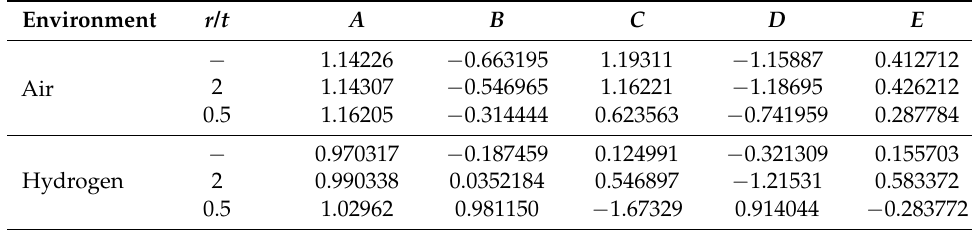
Table 1. Coefficients for Equation